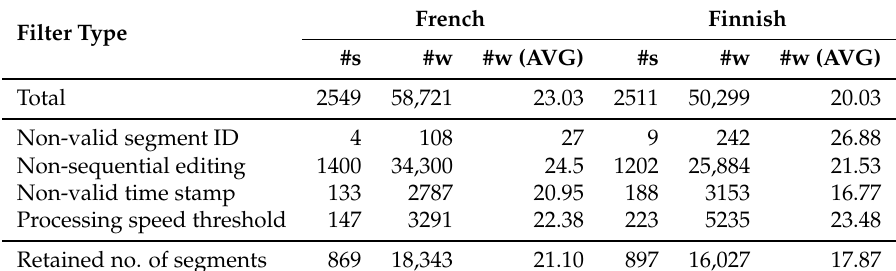
Table 2. The number of segments (#s), words (#w) and average number of words (#w (AVG)) filtered out by different methods for French and Finnish, after applying the filters in the given order.